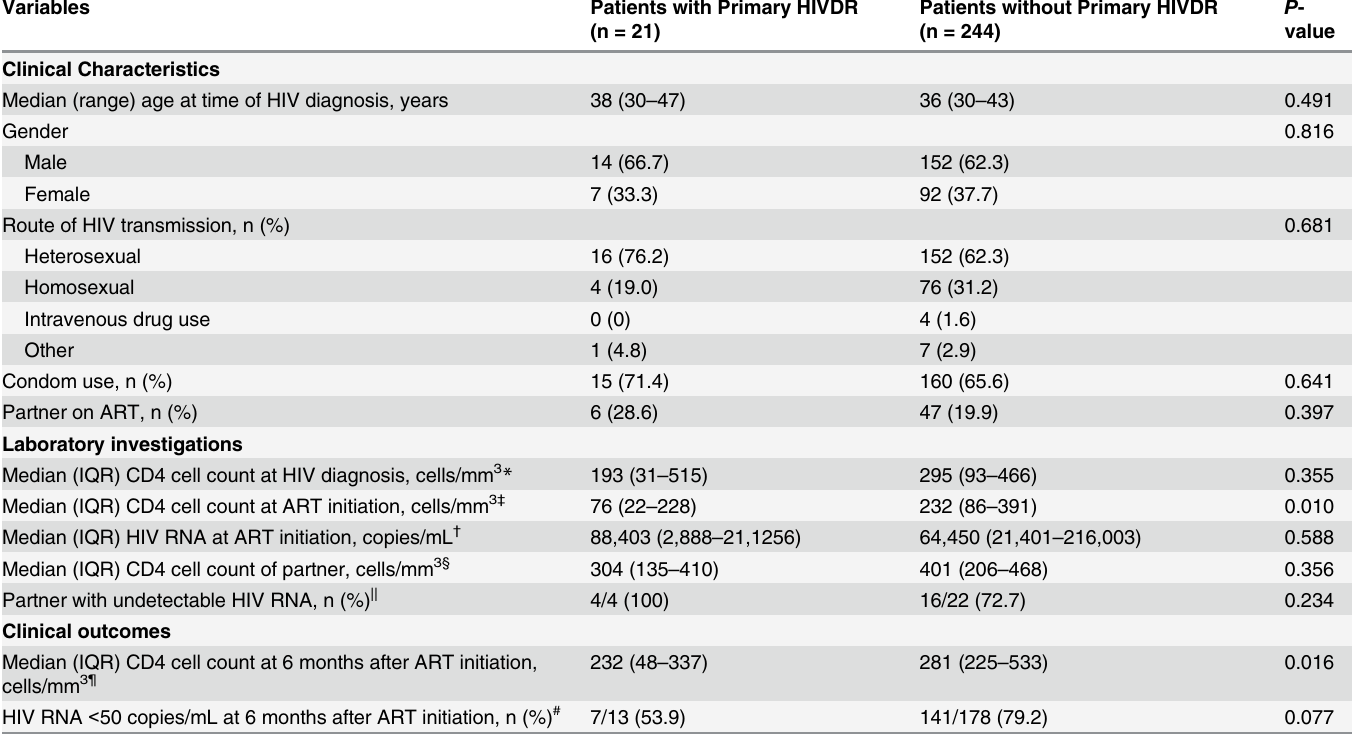
Table 2. Comparison of Clinical Characteristics, Laboratory Investigations, and Clinical Outcomes between Patients with and without Primary HIV Drug